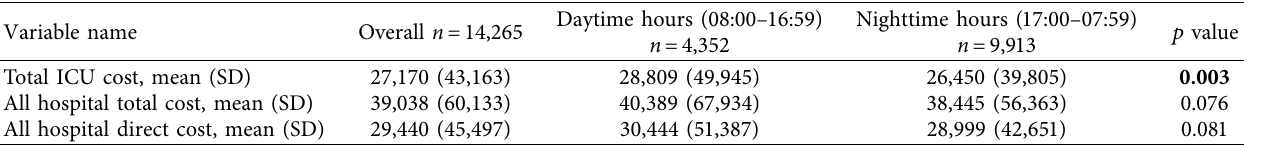
Table 4: Costs by admission time